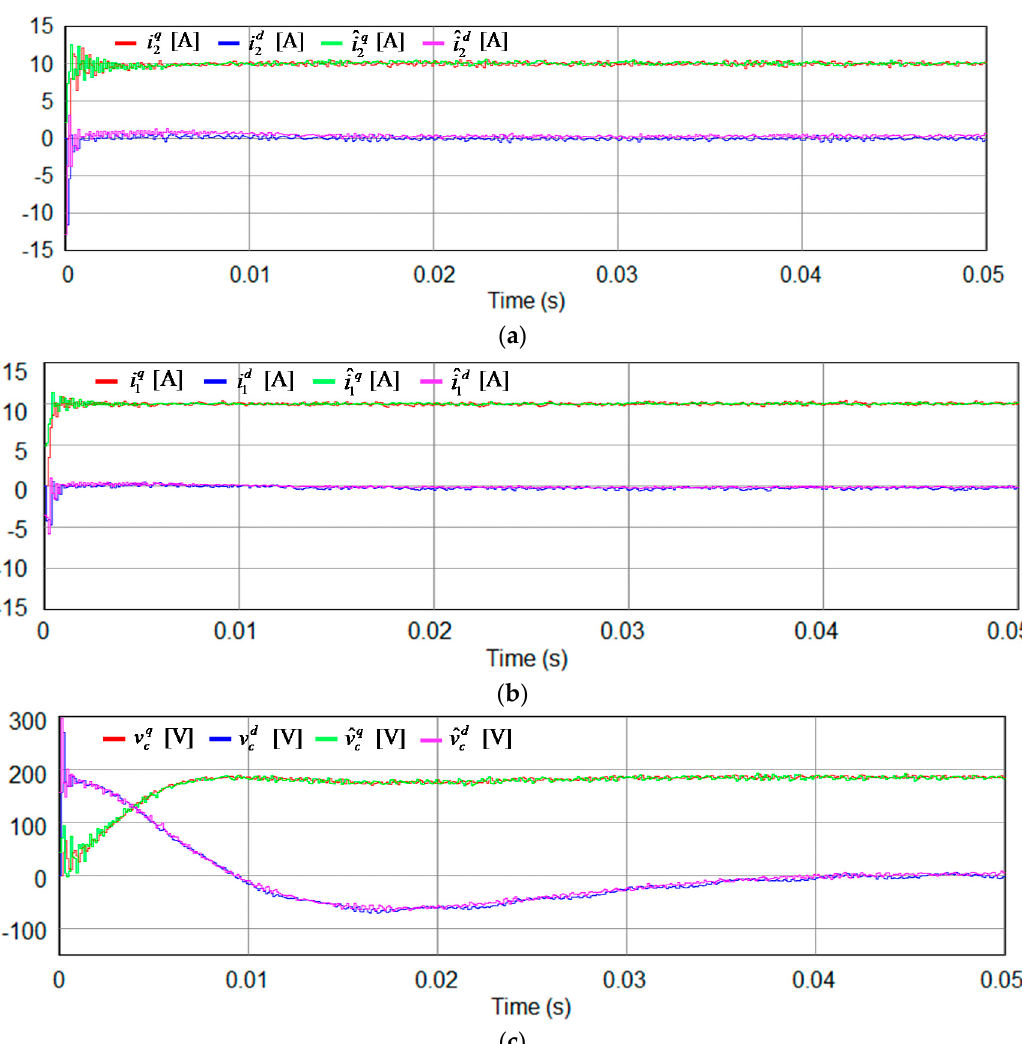
Figure 4. Simulation results for the inverter states and estimated states using the proposed discrete-time integral state feedback control scheme with state observer. ( a ) Waveforms of grid-side currents and estimated states at the synchronous reference frame (SRF); ( b ) Waveforms of inverter-side currents and estimated states at the SRF; ( c ) Waveforms of capacitor voltages and estimated states at the SRF.